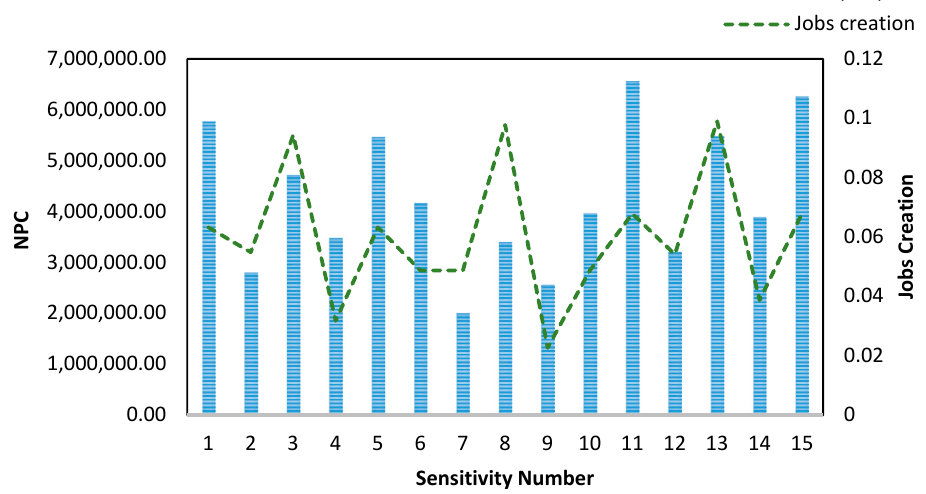
Figure 15. NPC and jobs creation for different sensitive cases.